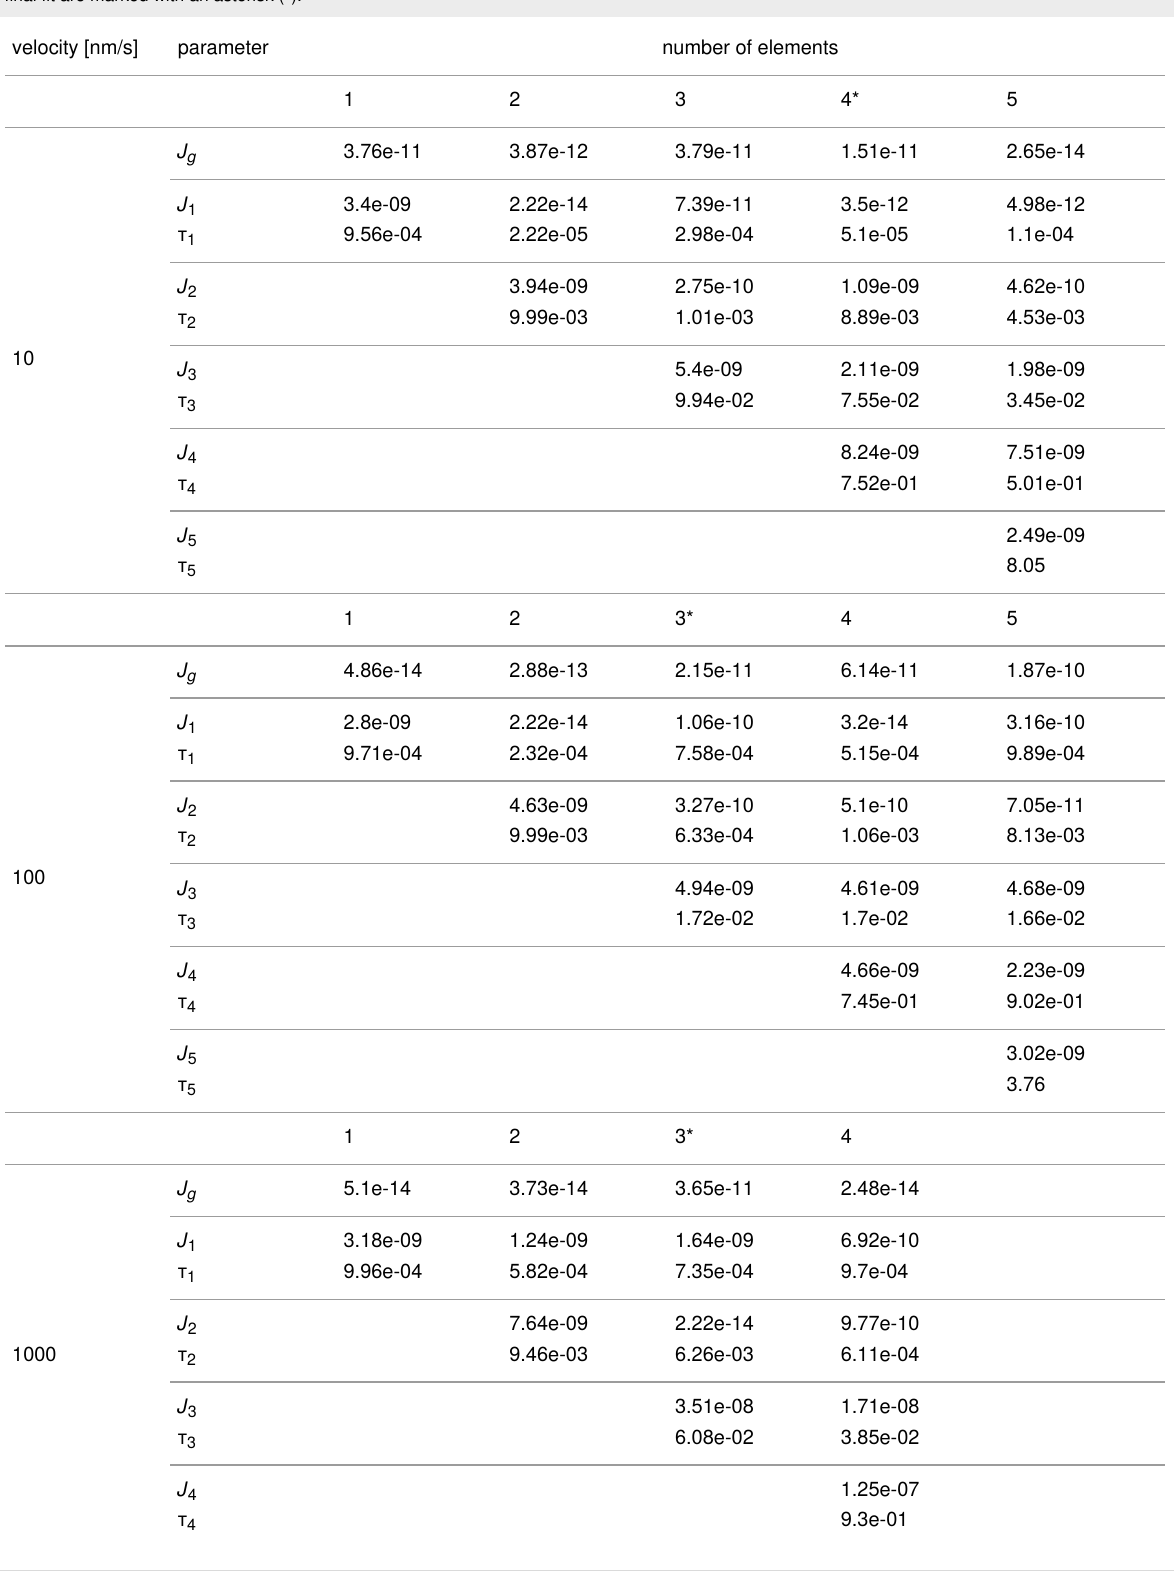
Table 2: Generalized Kelvin–Voigt viscoelastic model parameter sets resulting from nonlinear least-squares fits of AFM-SFS force–indentation data. Characteristic times are given in units of [s], and compliances are provided in units of [Pa − 1 ]. Note that the parameter sets utilized for generating the final fit are marked with an asterisk